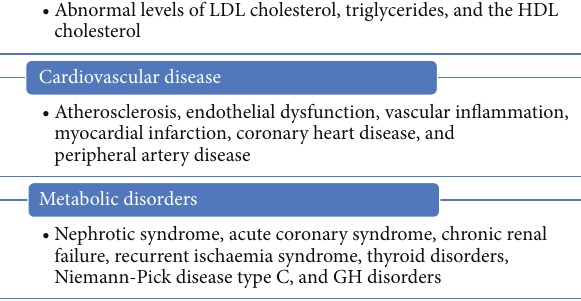
Figure 1: Showing important lipid abnormalities and metabolic disorders related to human cardiovascular